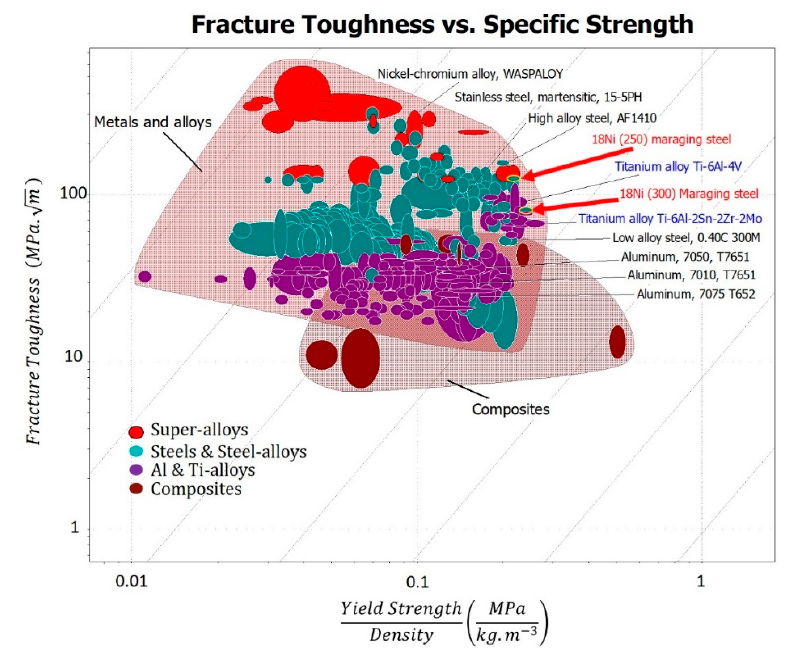
Figure 3. Ashby chart with topmost materials in terms of Fracture Toughness versus Specific Strength.